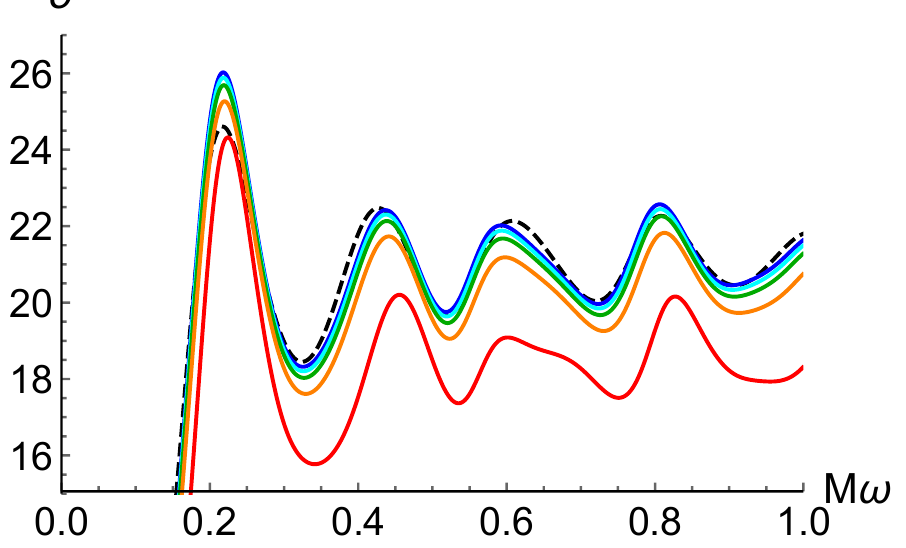
Figure 5. Emission cross-section for a fermionic field, with energy ω , for a loop BH of mass M . From bottom to top: (cid:101) = 10 {− 0.3, − 0.6, − 0.8, − 1, − 3 } . The dashed dark curve corresponds to the Schwarzschild cross-section. From